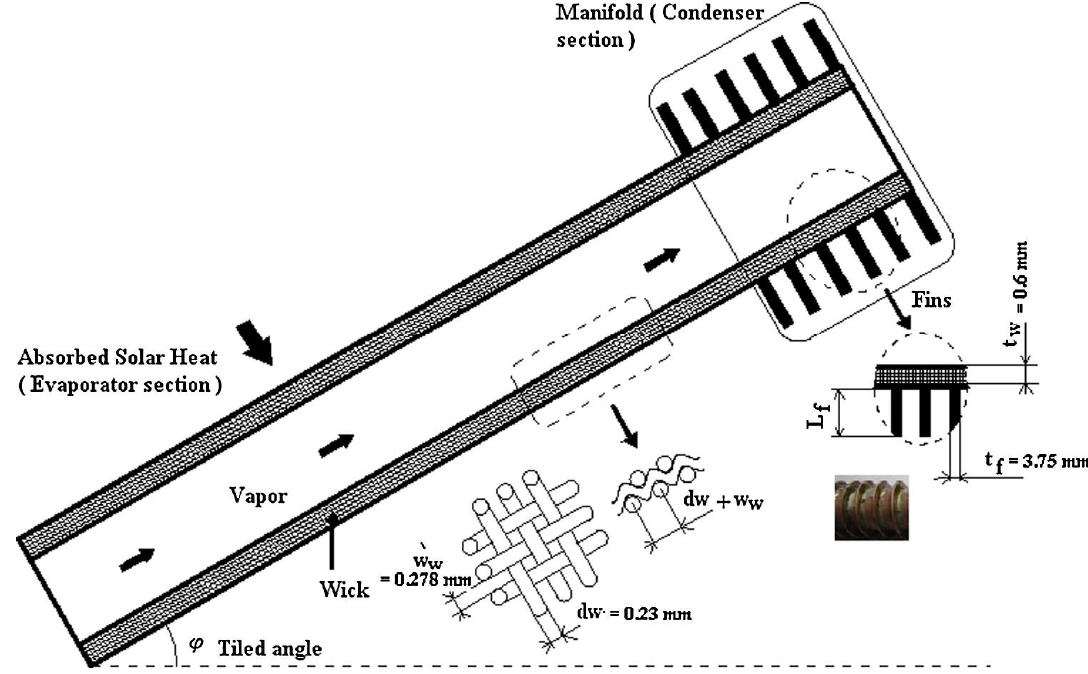
Figure 3. A detailed description of the heat pipe studied by Brahim et al. [15].